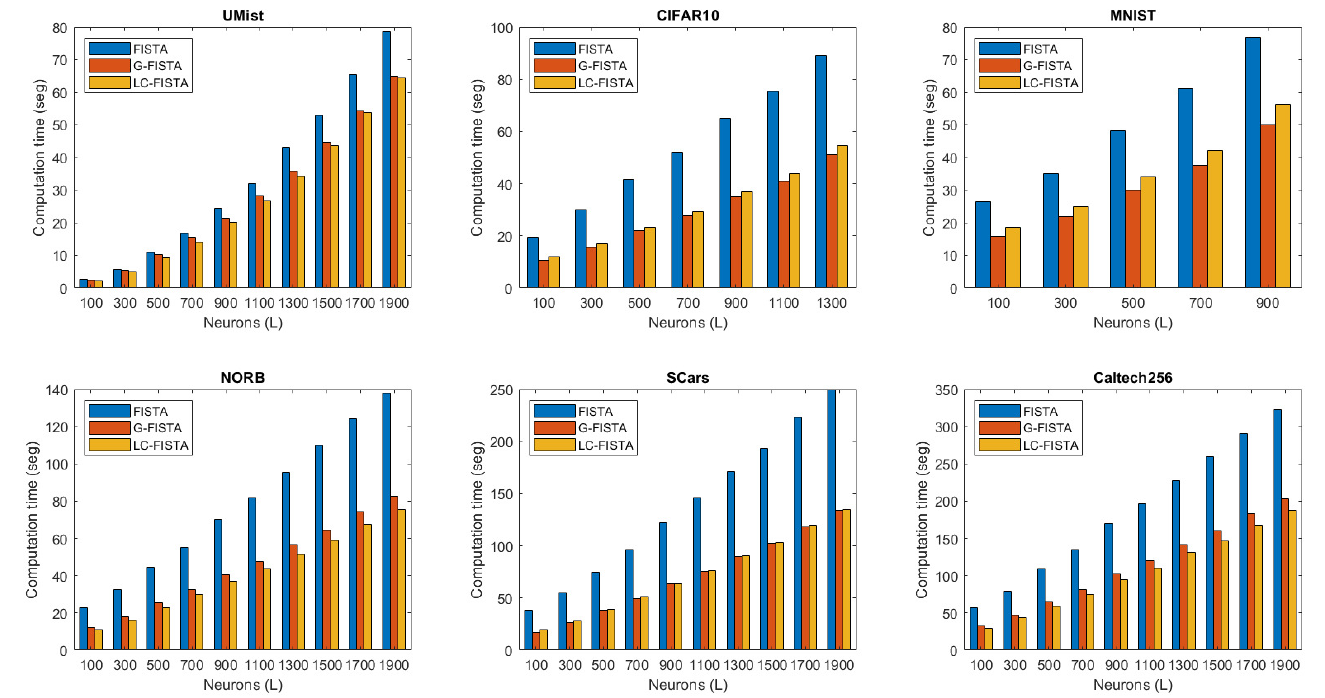
Figure 2. Bar graph representing the average training times required by FISTA, G-FISTA, and LC-FISTA for the